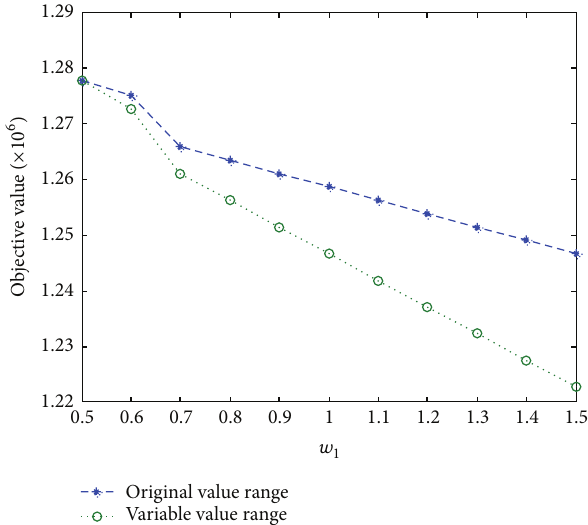
Figure 4: Solution of the train paths distributing model.